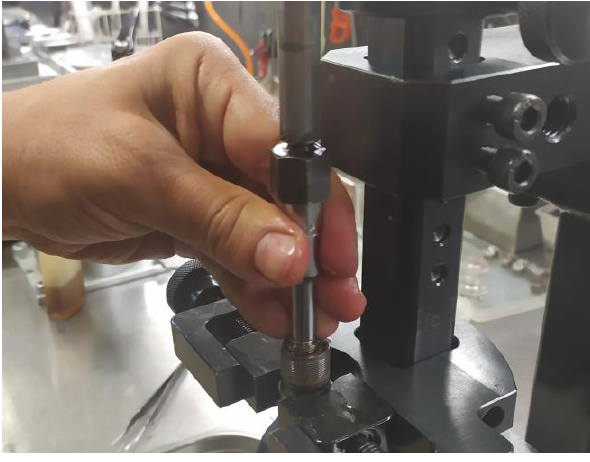
Fig. 11. Pressing step in the presence of oil